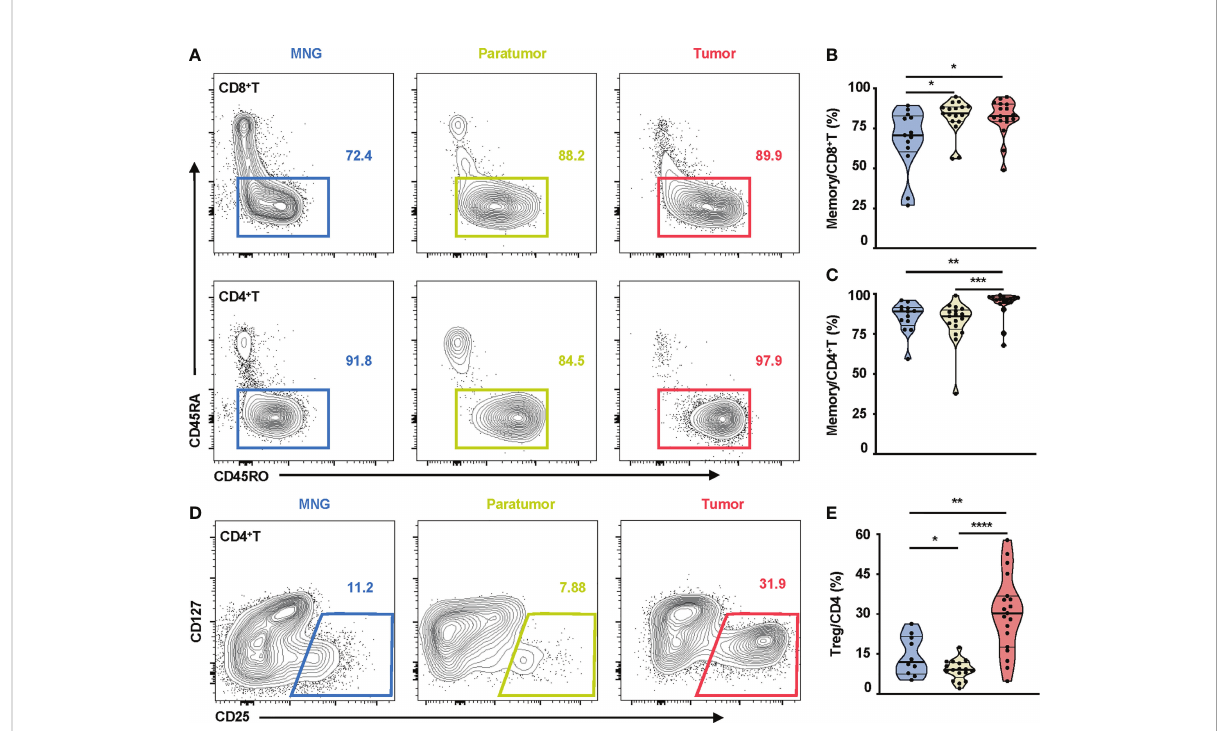
FIGURE 2 Memory T cells and Treg cells in thyroid tissues from MNG and PTC patients. (A) Representative FACS plots show CD45RO and CD45RA expressions on CD8 + T and CD4 + T cells. The values within solid line boxes indicate the proportions of memory T cells (CD45RO + CD45RA - ) to CD8 + T or CD4 + T cells. (B) Frequencies of memory T cells relative to CD8 + T cells are shown. (C) Frequencies of memory T cells relative to CD4 + T cells are shown. (D) Representative FACS plots show CD25 and CD127 expressions on CD4 + T cells. The values within solid line boxes indicate the proportions of Treg cells (CD25 + CD127 - ) to CD4 + T cells. (E) Frequencies of Treg cells relative to CD4 + T cells are shown. Blue means MNG, yellow means paratumor, and red means tumor. (B – E) Data presented as mean ± SEM. *p < 0.05; **p < 0.01; ***p < 0.001; ****p <